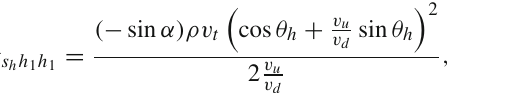
Fig. 3 a Illustratingthediphotonbranchingratiofor s h decayasafunc- tionofthevector-likeleptonmassfortwodifferent values ofthelightest VLQ mass ( M xd ). b The on-shell s h production cross section at LHC √ 1 s = 13 TeV through gluon fusion as a function the singlet VEV with